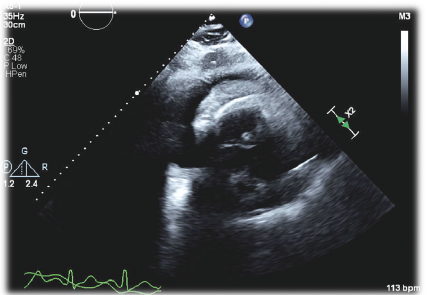
Figure 3: Echocardiogram showing tamponade with solid com- ponent in effusion consistent with fibropurulent